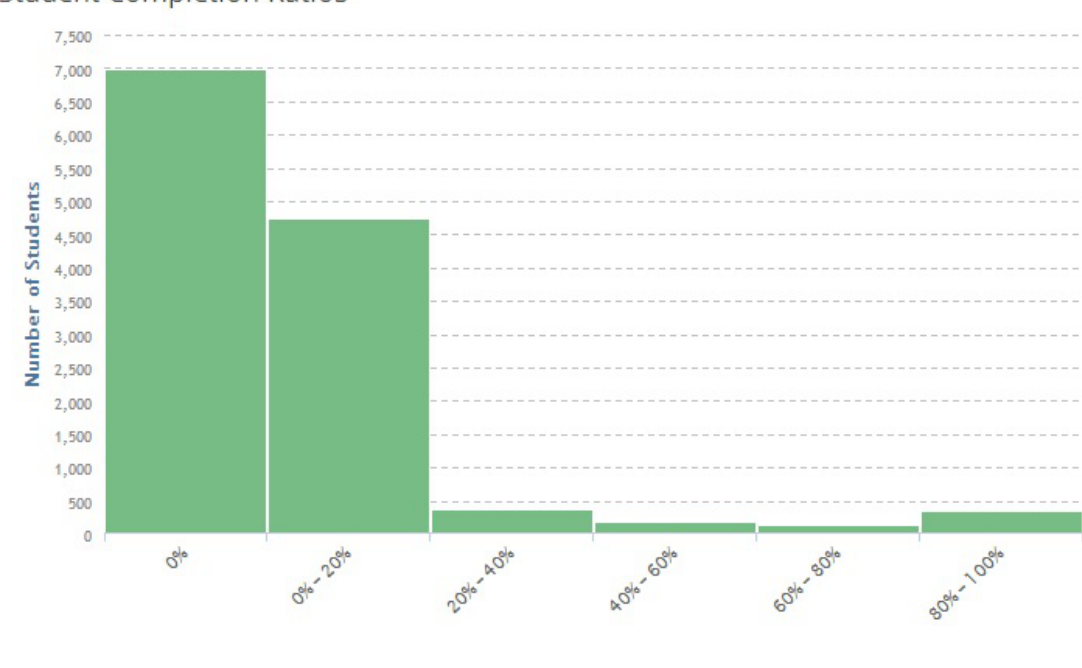
Figure 5. Student completion statistics after just over a year of operation of the MOOC Astronomy – State of the Art. Nearly 7,000 out of the nearly 13,000 enrolled never access the materials so they are “phantom” students. A large number access less than 20% of the materials; enough to get a flavor of the subject. A small percentage complete more than half of the materials, and the last bin shows an increase from the dedicated cohort who persist to the end of the